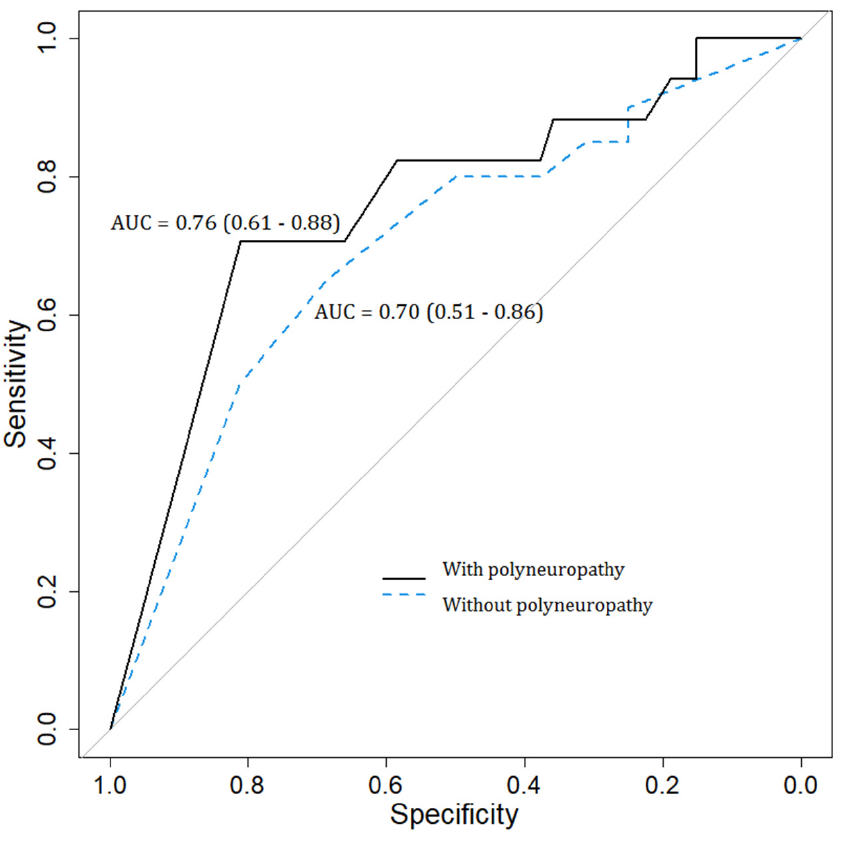
Figure 2. Area under the curve values of the CTS-6 questionnaire according to nerve conduction studies in subjects with and without diabetic polyneuropathy.